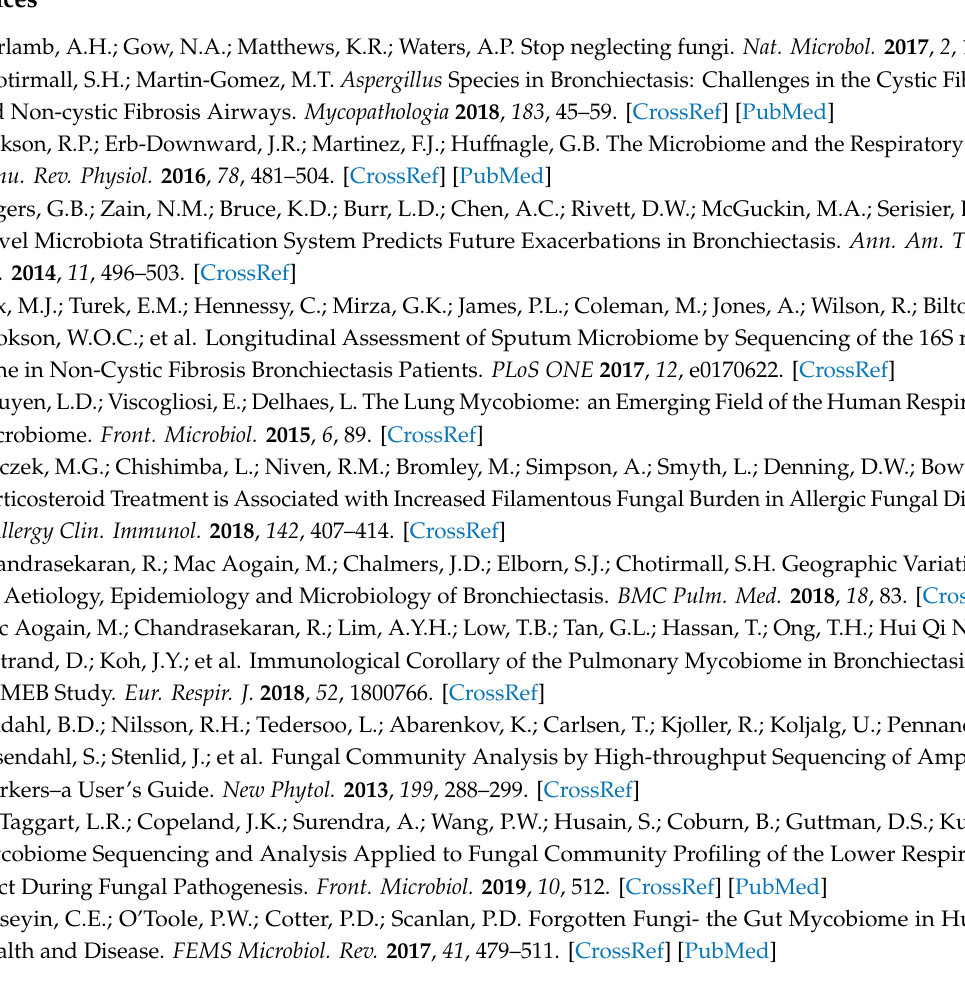
Supplementary Materials: Supplementary Table S1: FUNGuild analysis of top 40 ecological guild units identified in clinical specimens. The top 40 OTUs identified in clinical specimens (Figure 5) are indicated according to their closest matched species hypothesis within the UNITE database. Output from the FUNGuild database are indicated including taxon, rank, trophic mode, guild, confidence ranking, growth form, trait notes, and data source /